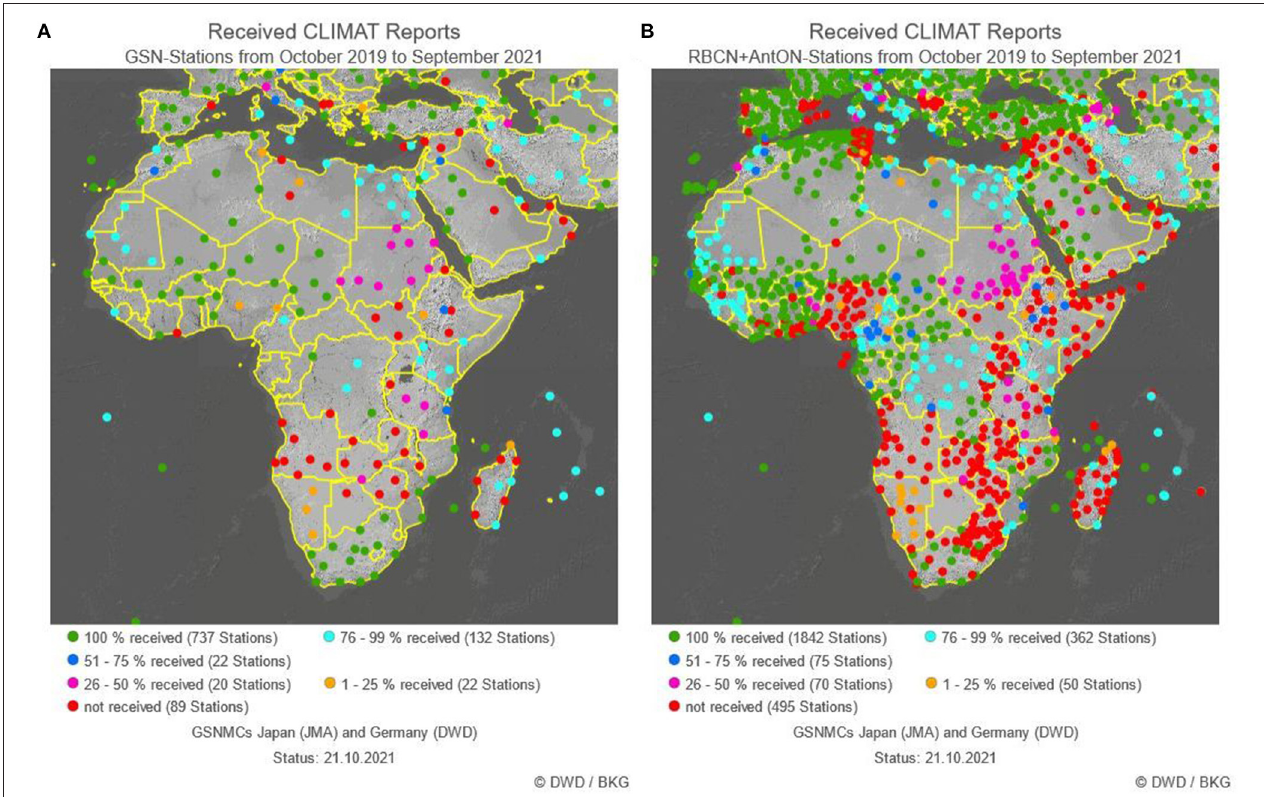
FIGURE 1 | Percentage of monthly CLIMAT reports that have been received by one of the monitoring centers (at DWD and JMA) for the period October 2019 to September 2021 (i.e., a 24 months period). Percentage refers to the expected number of reports from each station. (A) Percentage of GSN-stations, (B) percentage for the RBCN- and AntON-stations. Both figures produced via the interactive website of the GSNMC: https://www.dwd.de/DWD-GCOS/EN/nationalcontributions/